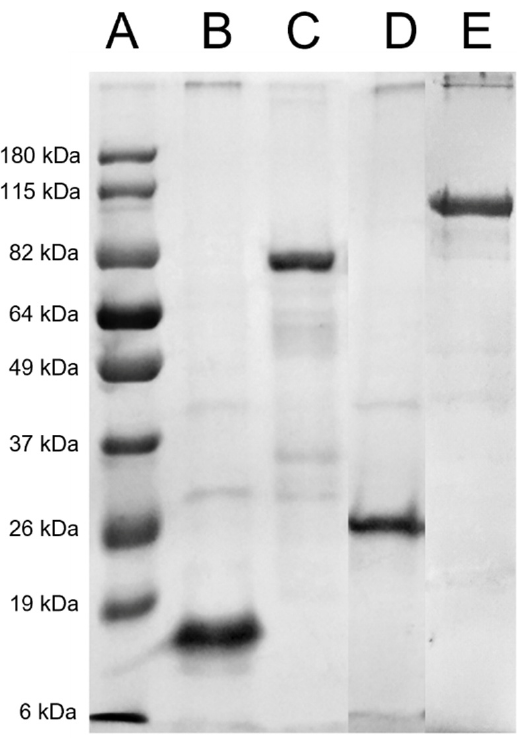
Figure 1. SDS-PAGE of purification at 12%. Recombinant proteins from C. pseudotuberculosis were produced in a heterologous system and stained with Coomassie blue. ( A ) Standard curve, ( B ) rSodC, ( C ) rNanH, ( D ) rPLD, and ( E ) rSpaC.